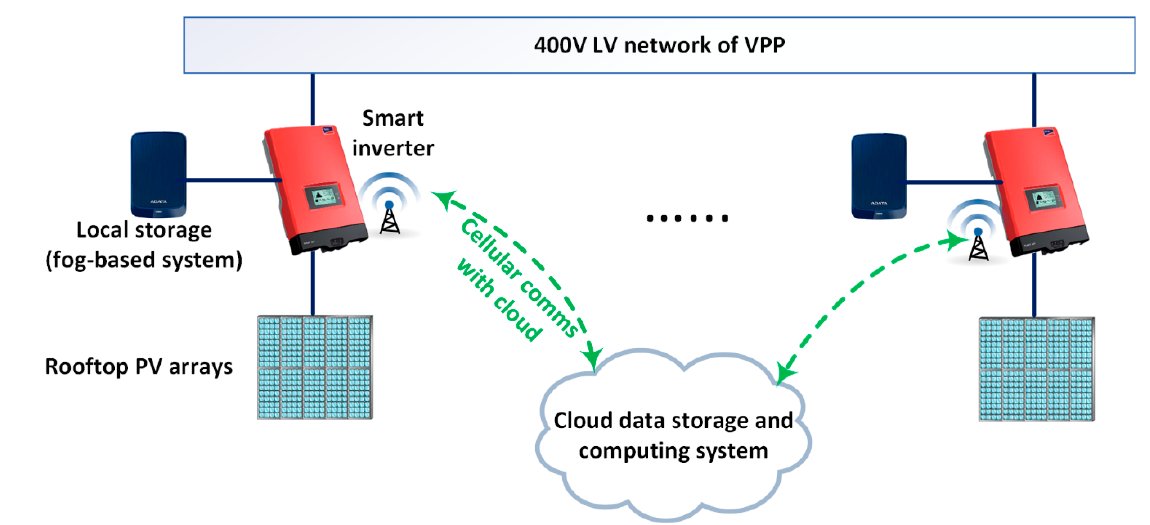
Figure 6. The proposed configuration of the monitoring and control system for PV systems in the VPP. Table 2. The signals necessary to collect and send to the cloud from the inverters of PV and battery systems.